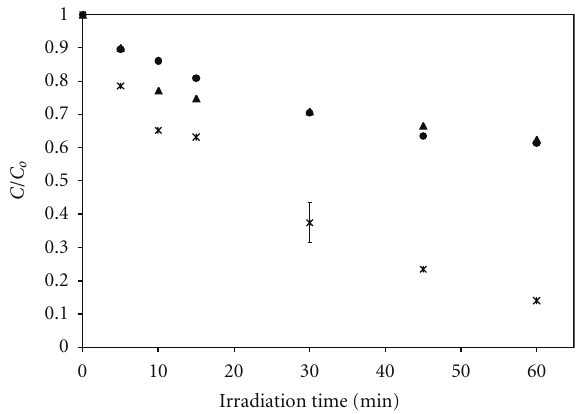
Figure 2: Comparison of degradation e ffi ciency of abamectin using di ff erent AOPs: — (cid:4) — H 2 O 2 /UV; — (cid:2) — Fenton reaction; — ∗ — photo-Fenton reaction. Initial conditions: [H 2 O 2 ] = 6.0 mmolL − 1 ; [Fe 3+ ] = 5.0mmolL − 1 ; abamectin = 9.0 mgL − 1 , λ = 365 nm; pH = 2.5.